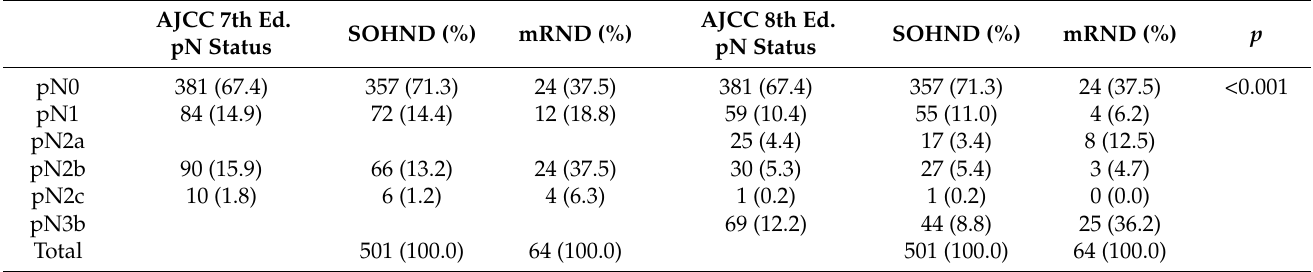
Table 2. Relationship between pathologic nodal status and type of ND in different AJCC editions.